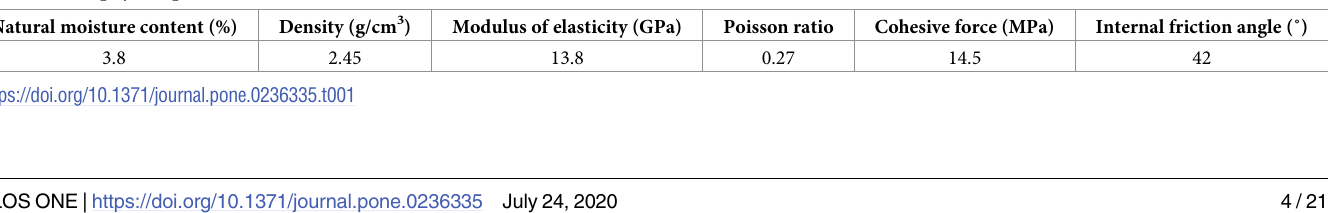
Table 1. Basic physical parameters of